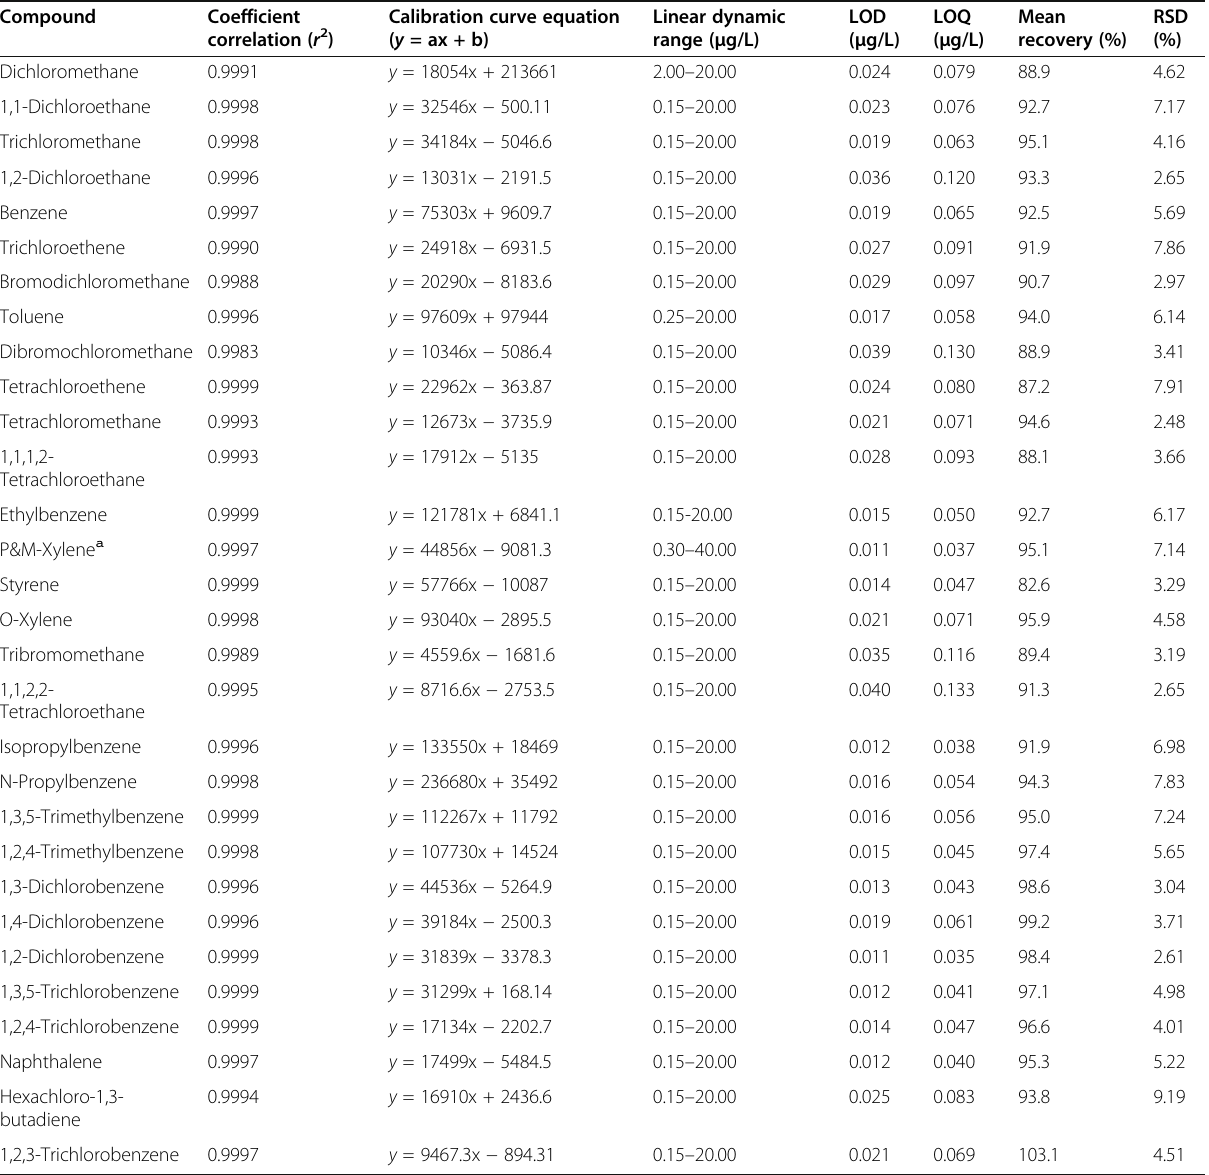
Table 2 Linearity, LODs, LOQs, and accuracy study of VOCs Compound Coefficient correlation ( r 2